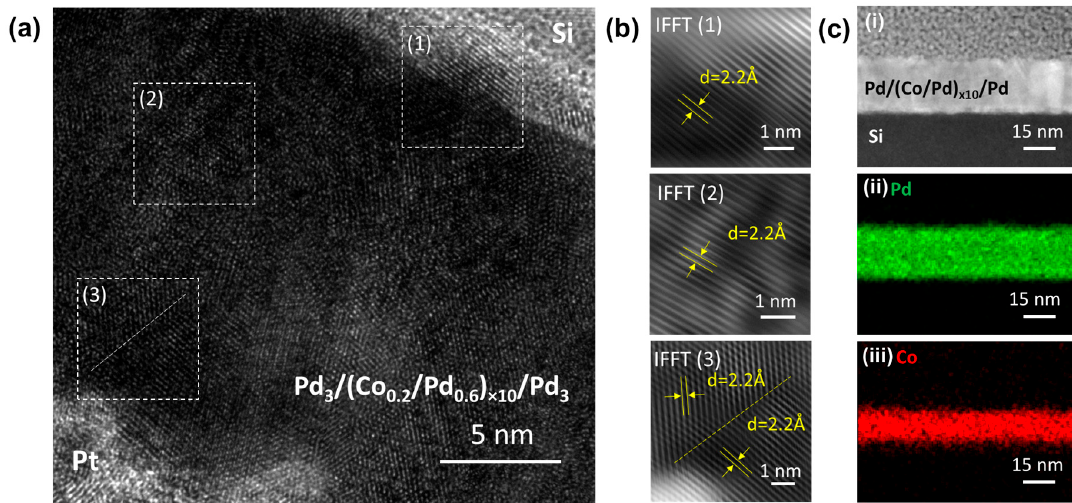
Figure 9. ( a ) High-resolution transmission electron microscopy (HR-TEM) image of sample (Co 0.2 /Pd 0.6 ) ×10 (cross-sectional view). ( b ) The inverse fast Fourier transform (IFFT) images show the (111) direction. Dashed line in area (3) indicates the grain boundary. ( c ) Scanning